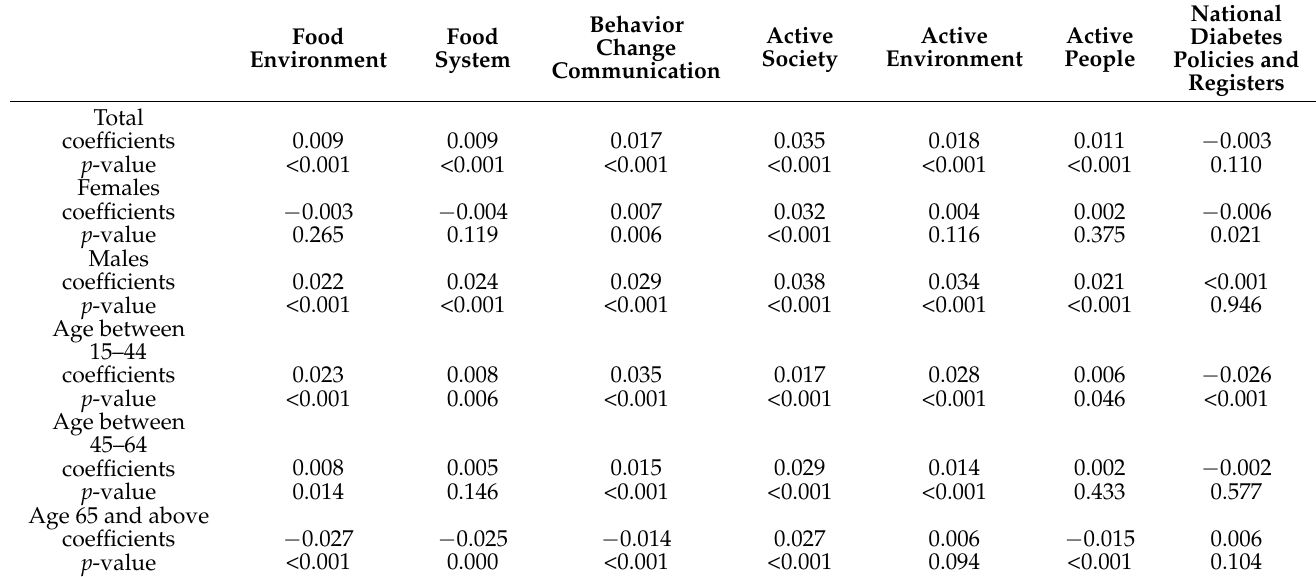
Table 3. Point biserial correlation coefficient between policies type and the prevalence of diabetes in 2014 in total population, and stratified by sex and age groups.